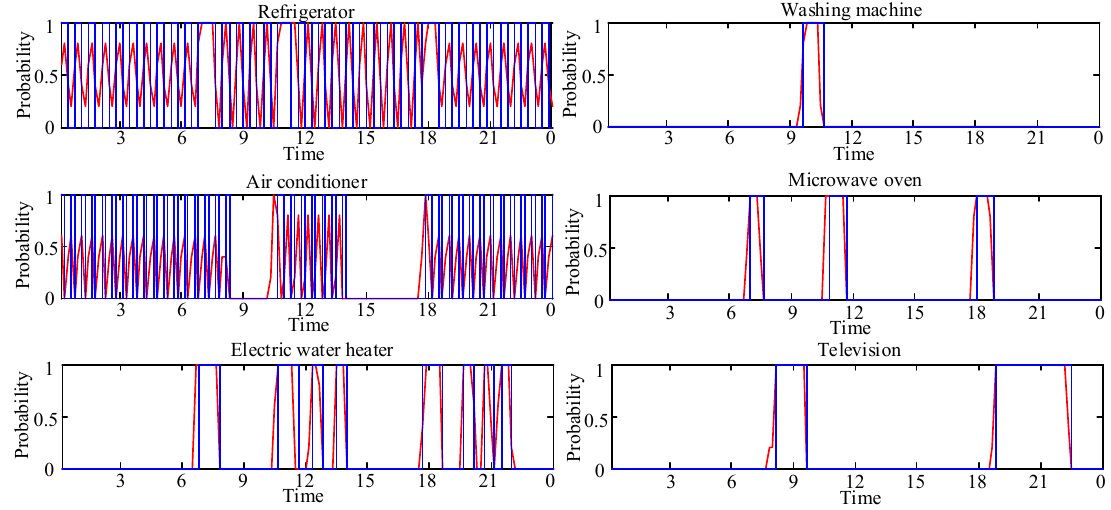
Figure 3. Consumption behavior of household